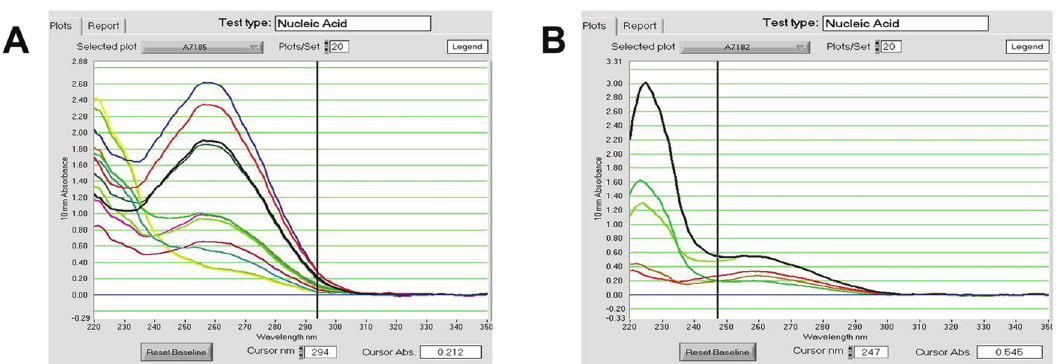
Figure 2. Representative graphical plots of total RNA extracted. ( A ) PAXM: analysis of whole blood showed peaks positioned at 230 nm (n=10) and ( B ) MP: analysis of PBMCs showed peaks positioned at 260 nm